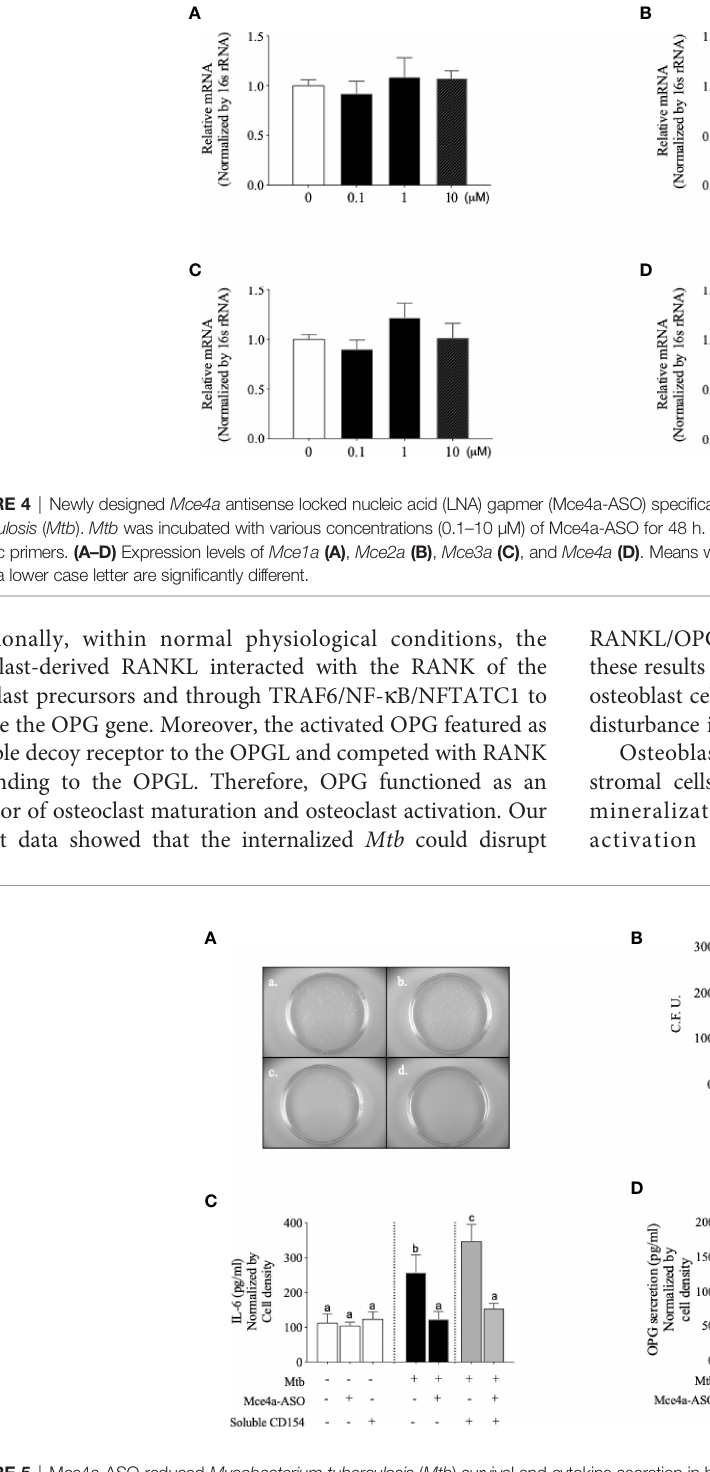
FIGURE 5 | Mce4a-ASO reduced Mycobacterium tuberculosis ( Mtb ) survival and cytokine secretion in human osteoblast cells. Osteoblast cells were incubated with Mtb in the presence or absence of Mce4a-ASO (0 – 10 µM) for 48 h. (A) Representative images of the colony forming unit (CFU) Petri dishes. ( a ) Mtb only. ( b ) Mtb infection with 0.1 µM Mce4a-ASO. ( c ) Mtb infection with 1 µM Mce4a-ASO. ( d ) Mtb infection with 10 µM Mce4a-ASO. (B) The number of bacterial colonies was determined using ImageLab ® software. (C) The secretion level of interleukin 6 (IL-6) was measured using a commercially available ELISA kit. (D) Osteoprotegerin produced by osteoblasts